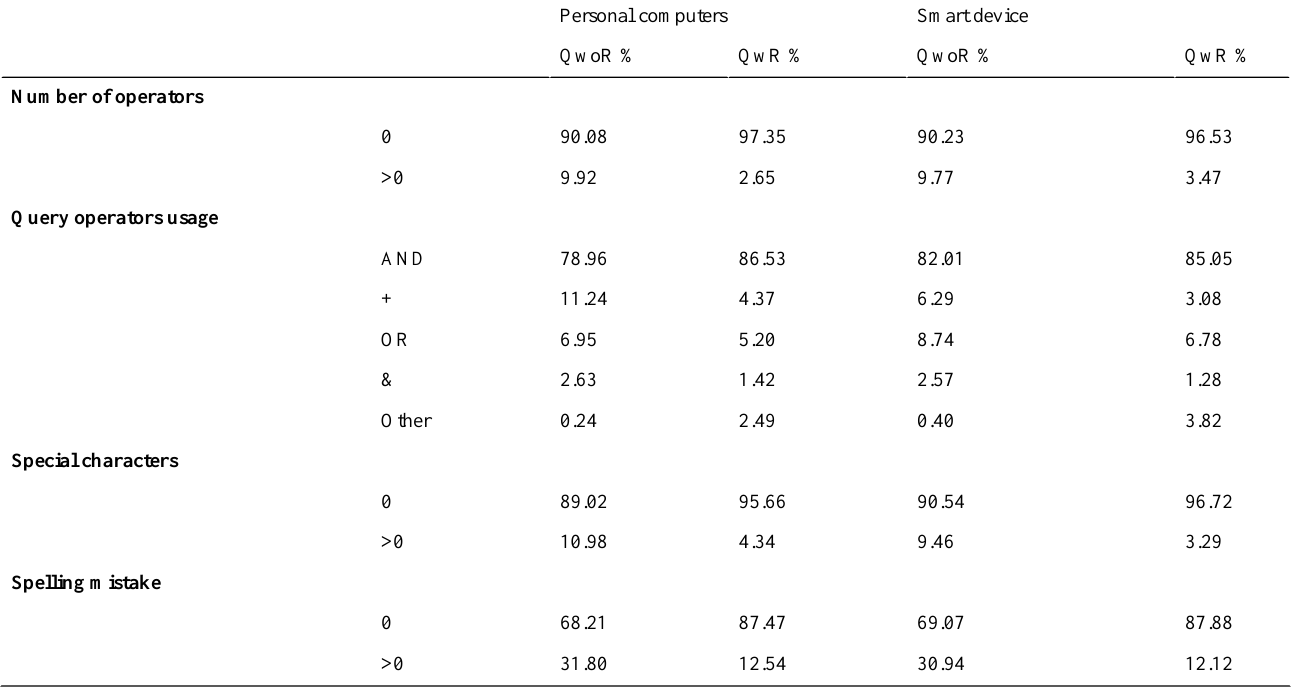
Table 2. Usage of query operators and special characters (June 11-May